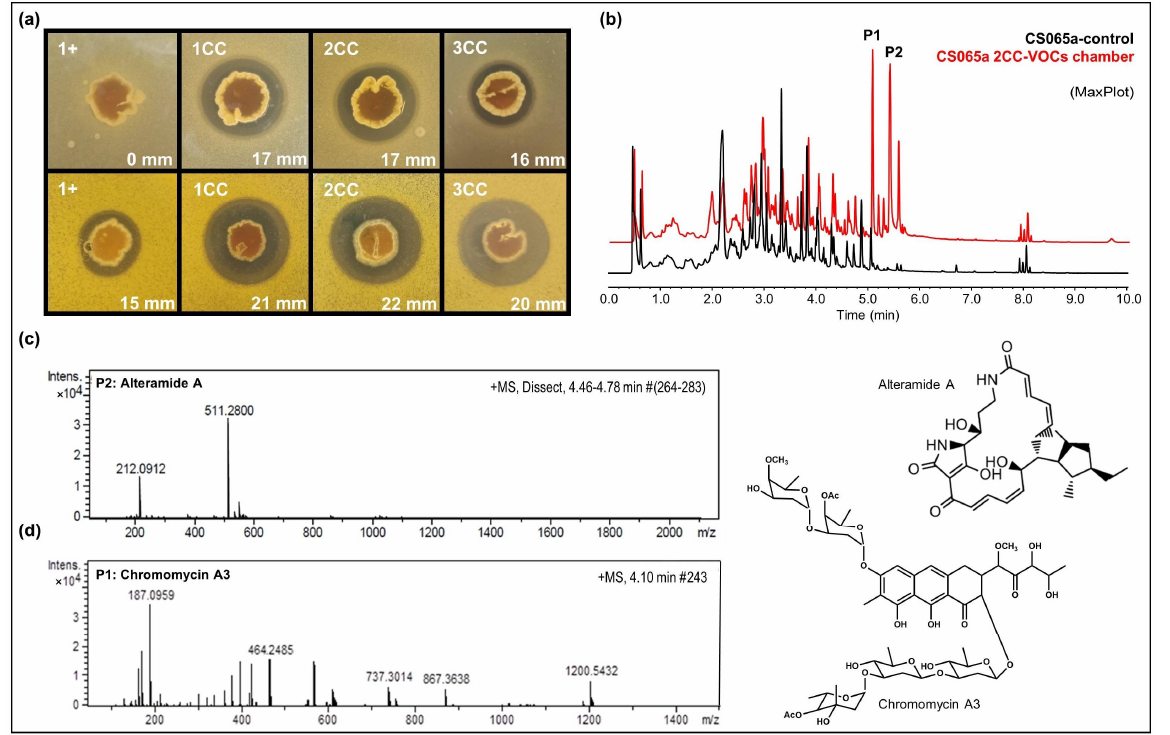
Figure 6. Results of multiple co-culture of CS065a on SFM. ( a ) Bioassay against E. coli (first row) and M. luteus (second row). 1 + : Streptomyces CS065; 1CC: co-culture CS065a, CS113, CS147, and CS207; 2CC: co-culture CS065a, CS090a, CS147 and CS207; 3CC: coculture CS065a, CS090a, CS113 and CS207. ( b ) Comparative UPLC analysis (MaxPlot) of samples of CS065a in monoculture (black) versus in co-culture with CS090a, CS147, and 207 (red). Differential peaks are marked with an asterisk. ( c ) HRMS spectrum of alteramide A. ( d ) HRMS spectrum of chromomycin A3.